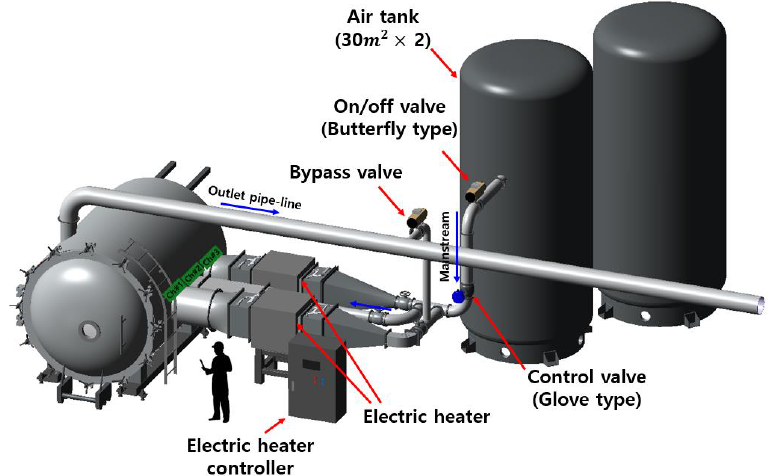
Figure 1. Transonic turbine cascade test rig.